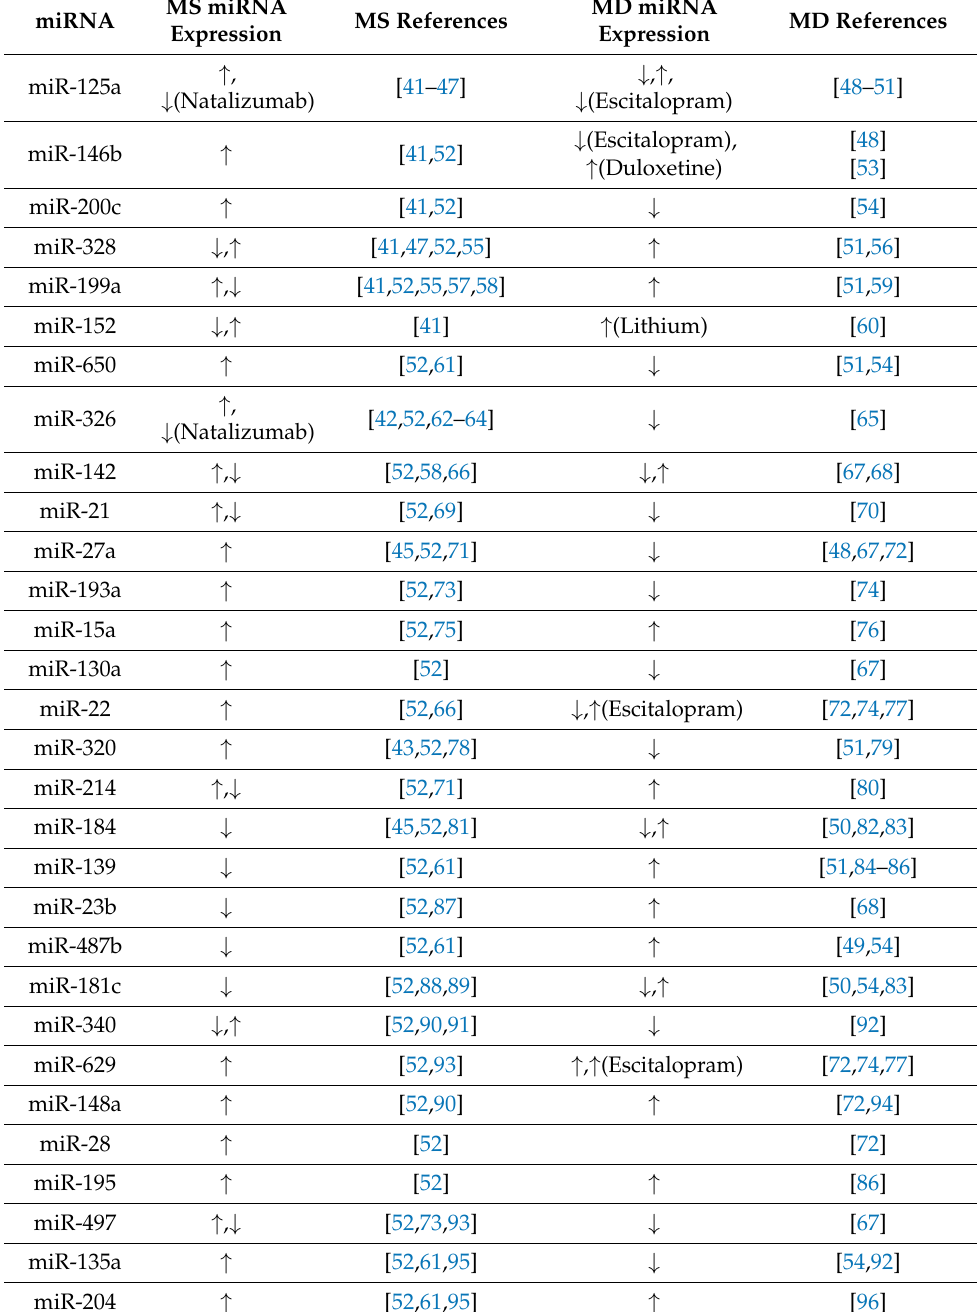
Table 1. The common miRNA biomarkers of MS and MD are provided. The expression information with parentheses means the expression information after the treatment of the drug. MS miRNA